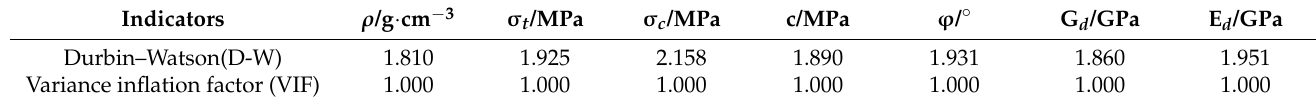
Table 4. Basic hypothesis